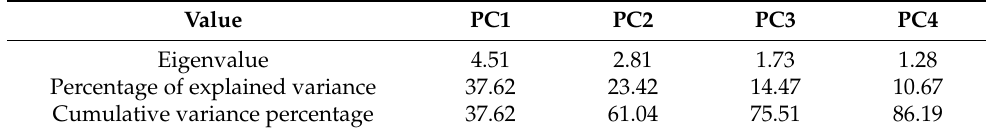
Table 8. Eigenvalue and percentage of variances retained by principal components that de- scribe the resistance mechanisms of the 11 races of maize to Tetranychus merganser at 48 h under laboratory